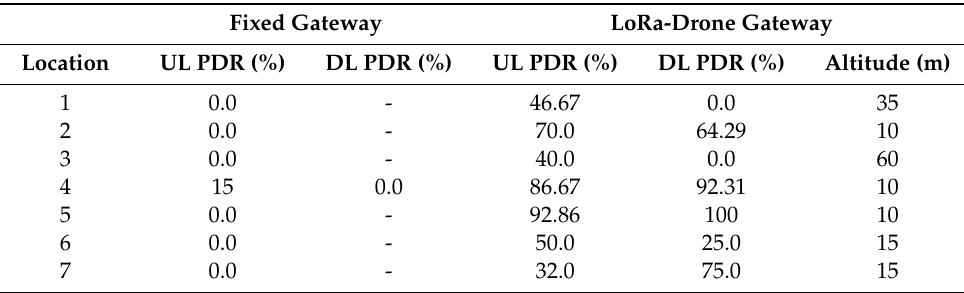
Table 3. PDR results for LoRa